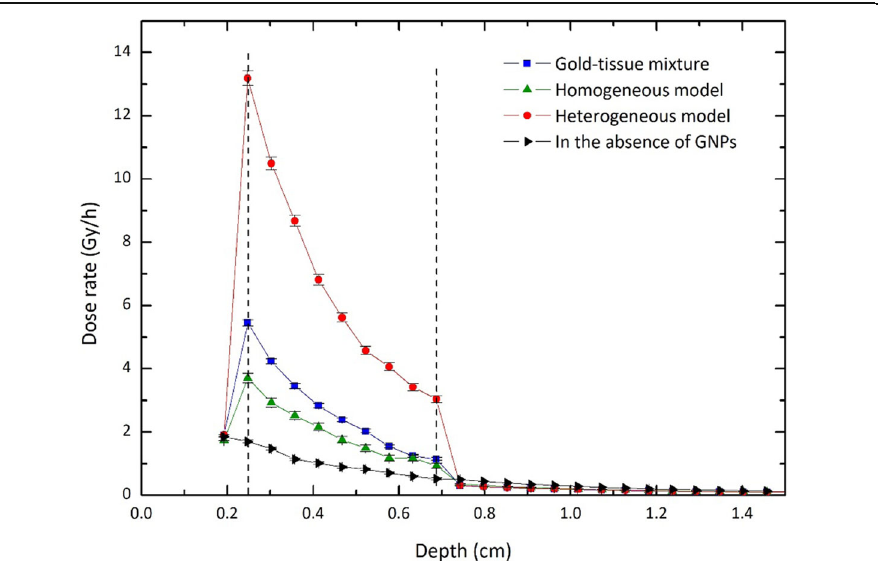
Fig. 4 The values of the dose rate (Gy/h) calculated in the depth of human eye phantom containing the tumor filled with GNPs of three models for the concentration of 30 mg/g with 100 nm diameter. The depth-dose rates in the absence of GNPs have also been reported. Error bars indicate the relative